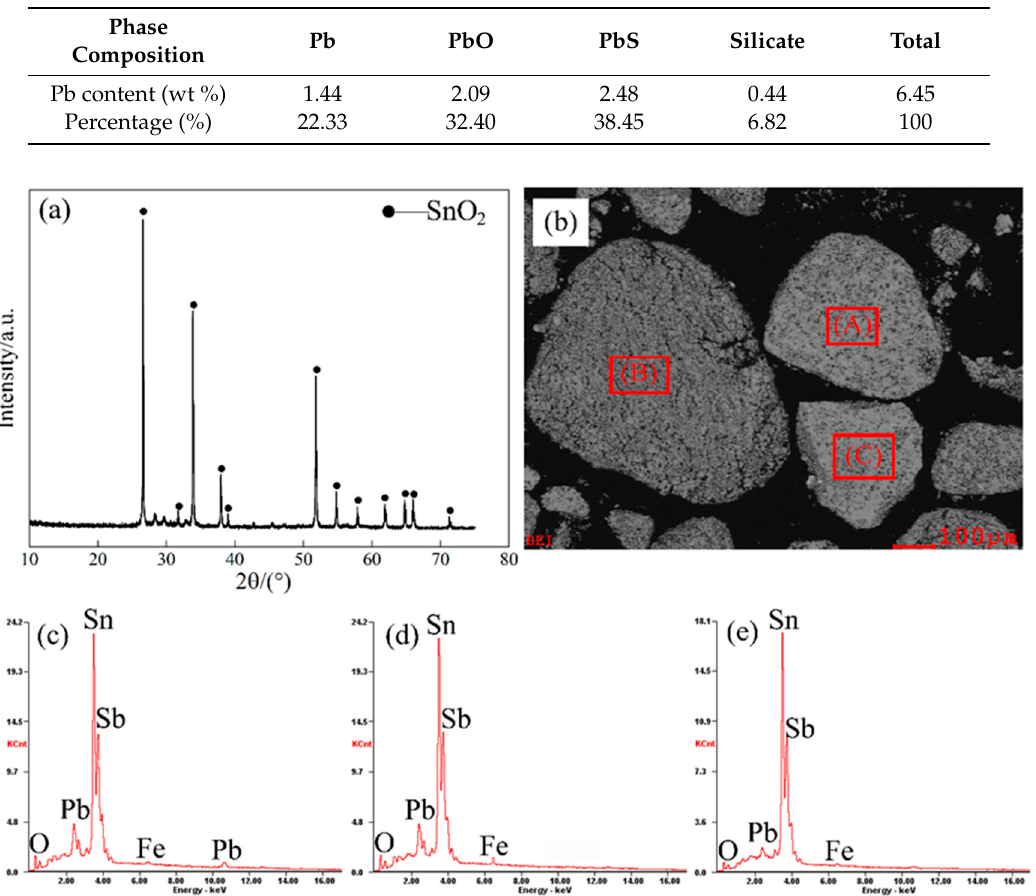
Table 3. Antimony phase composition of the lead refining dross.